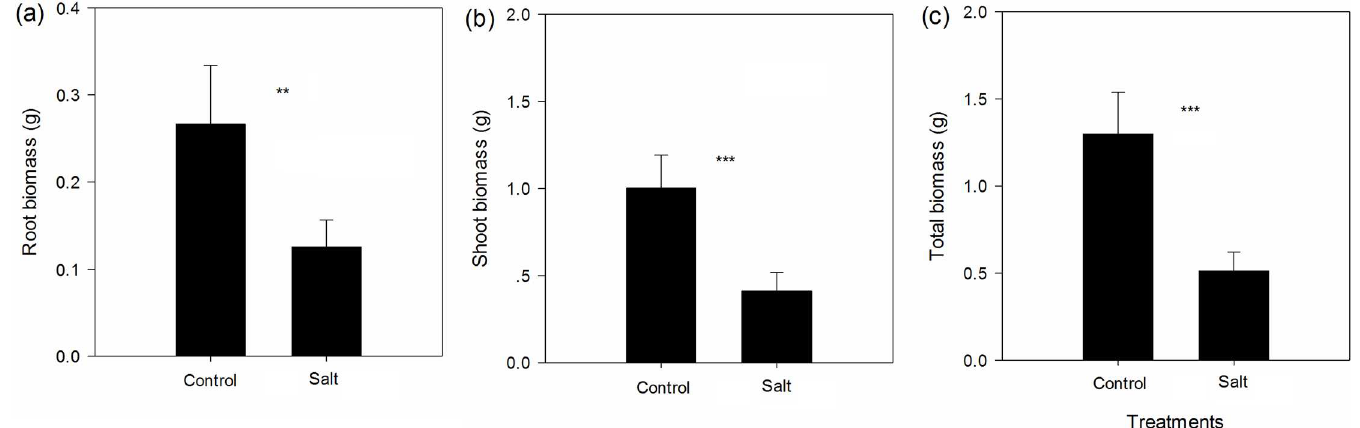
Fig 2. Effect of salt treatment on root biomass (a) shoot biomass (b) and total biomass(c). Values are shown in mean ± standarderror (SE). * , ** , *** , indicatethat the difference betweenthe control and salt treatment is significantat p < 0.05, p < 0.01 and p < 0.001,respectively.